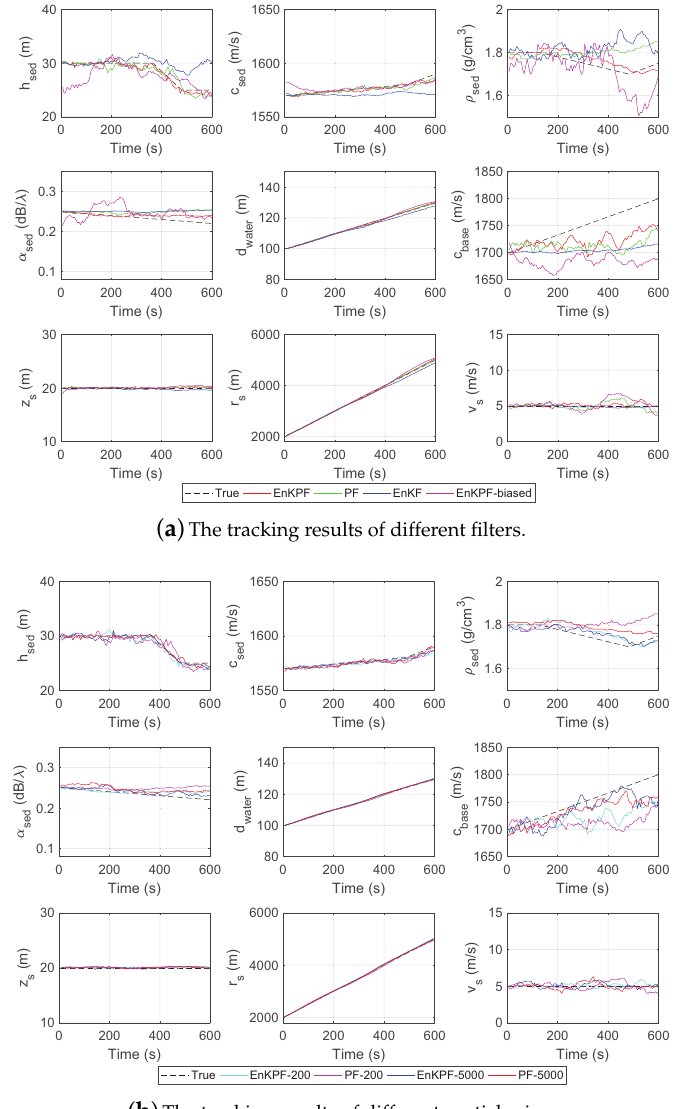
Figure 3. Tracking results for nine parameters in the simulation environment. The dotted lines denote the true trajectories. ( a ) EnKPF (red), PF (green) and EnKF (blue) are marked as different colors, while the random model tracked by EnKPF is marked as violet. ( b ) Tracking results of EnKPF and PF with different particle